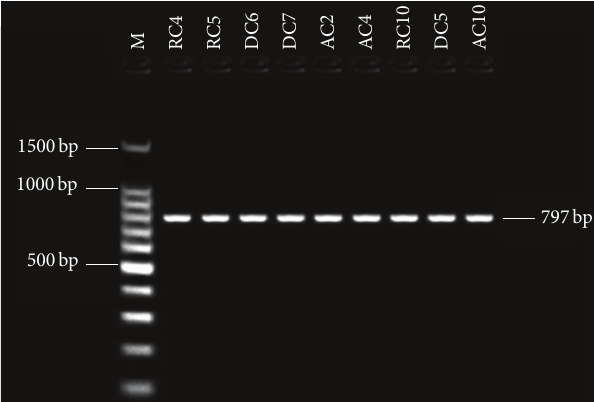
Figure 4: Gel electrophoresis analysis PCR products using ver-1 primer with 537 bp, lanes from RC4 to AC4 ( A. flavus ), lanes from RC10 to AC10 ( A. parasiticus ), and lane M: 100bp DNA ladder size marker.